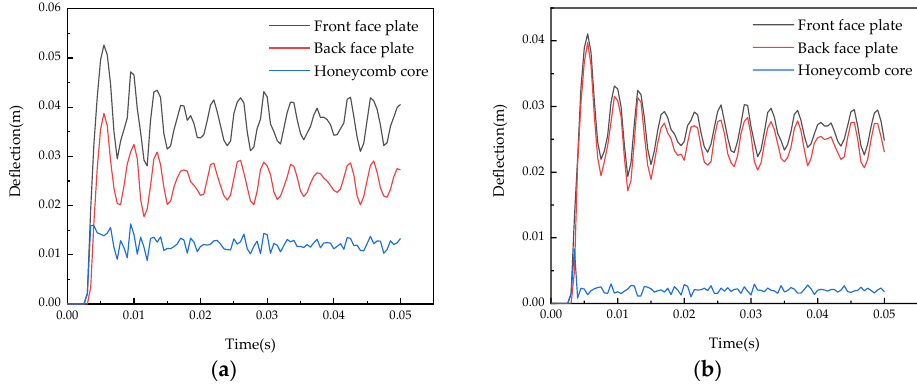
Figure 22. Deflection histories of centre points of face plates and honeycomb core. ( a ) Positive gradient; and ( b ) Negative gradient.